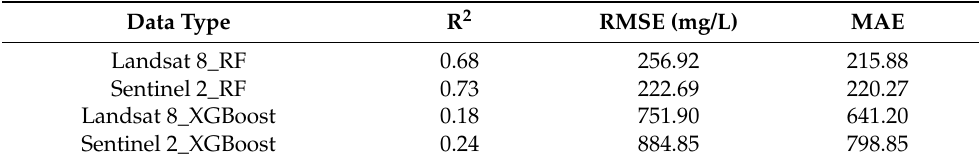
Table 4. Accuracy evaluation of SPM retrieval from original images.